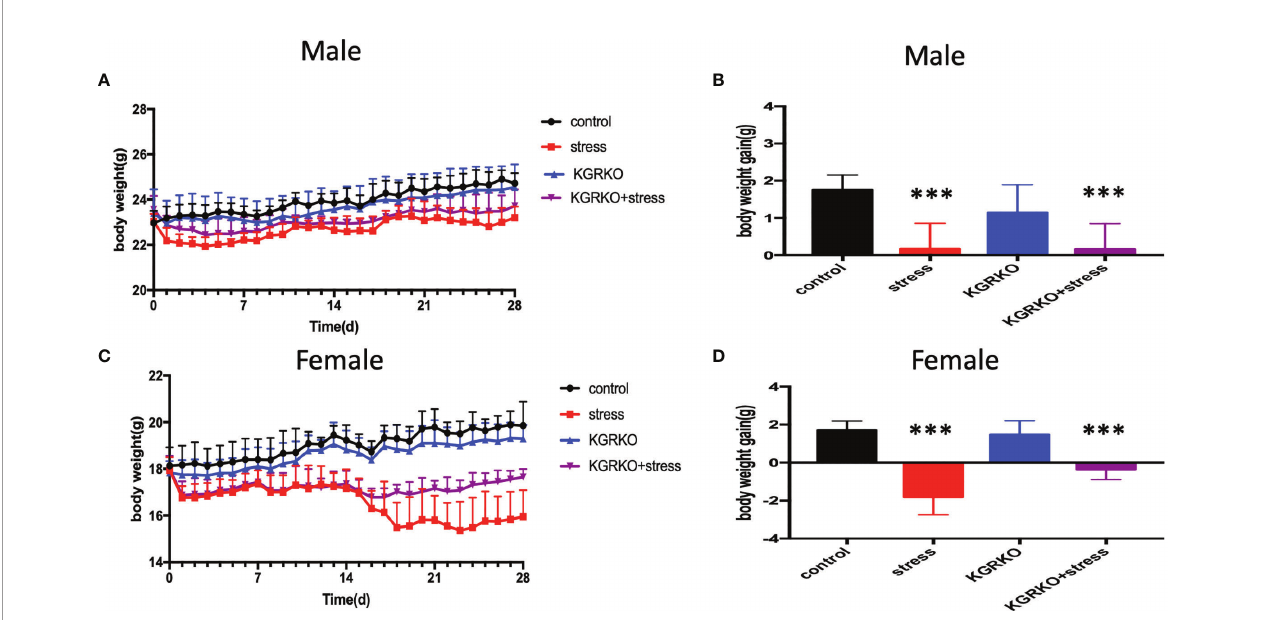
FIGURE 1 | The effect of chronic restraint stress on the body weight of KGRKO mice. control: control group, stress: restraint stress group. KGRKO group: Kisspeptin neuron-speci fi c GR knockout mice. KGRKO+stress group: Kisspeptin neuron-speci fi c GR knockout mice restraint stress group. (A, B) The effect of chronic restraint stress on the body weight of male KGRKO mice. (C, D) The effect of chronic restraint stress on the body weight of male KGRKO mice. ***Represents the comparison with the control group,